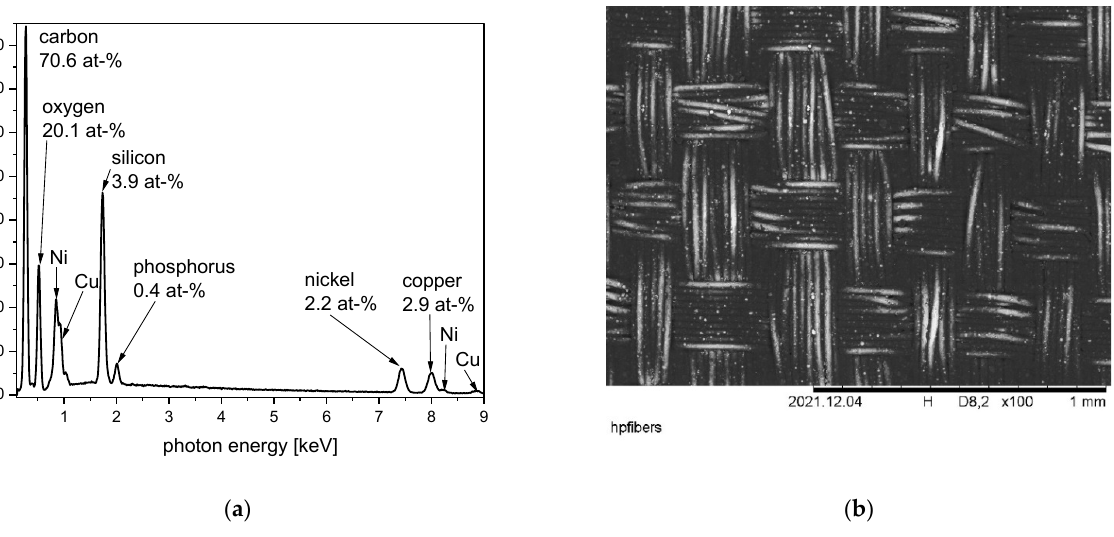
Figure 39. Presentation of a commercially available metallized fabric supplied under the name SR-Shield (SR Webatex GmbH, Bayreuth, Germany) offered for the shielding of radio waves (electrosmog): ( a ) EDS spectrum of this fabric with detected chemical elements and their determined concentration; ( b ) SEM image.